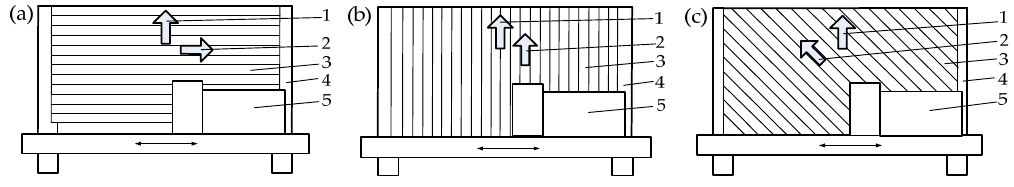
Figure 2. Schematic diagram of production different warp ‐ knitted unidirectional non ‐ crimp fabric (UD ‐ NCF): ( a ) the production of 90° Layers; ( b ) the production of 0° layers; and ( c ) the production of 45° layers. 1—Process direction; 2—Fiber direction; 3—Thread; 4—Transport system; 5—Weft carriage system.